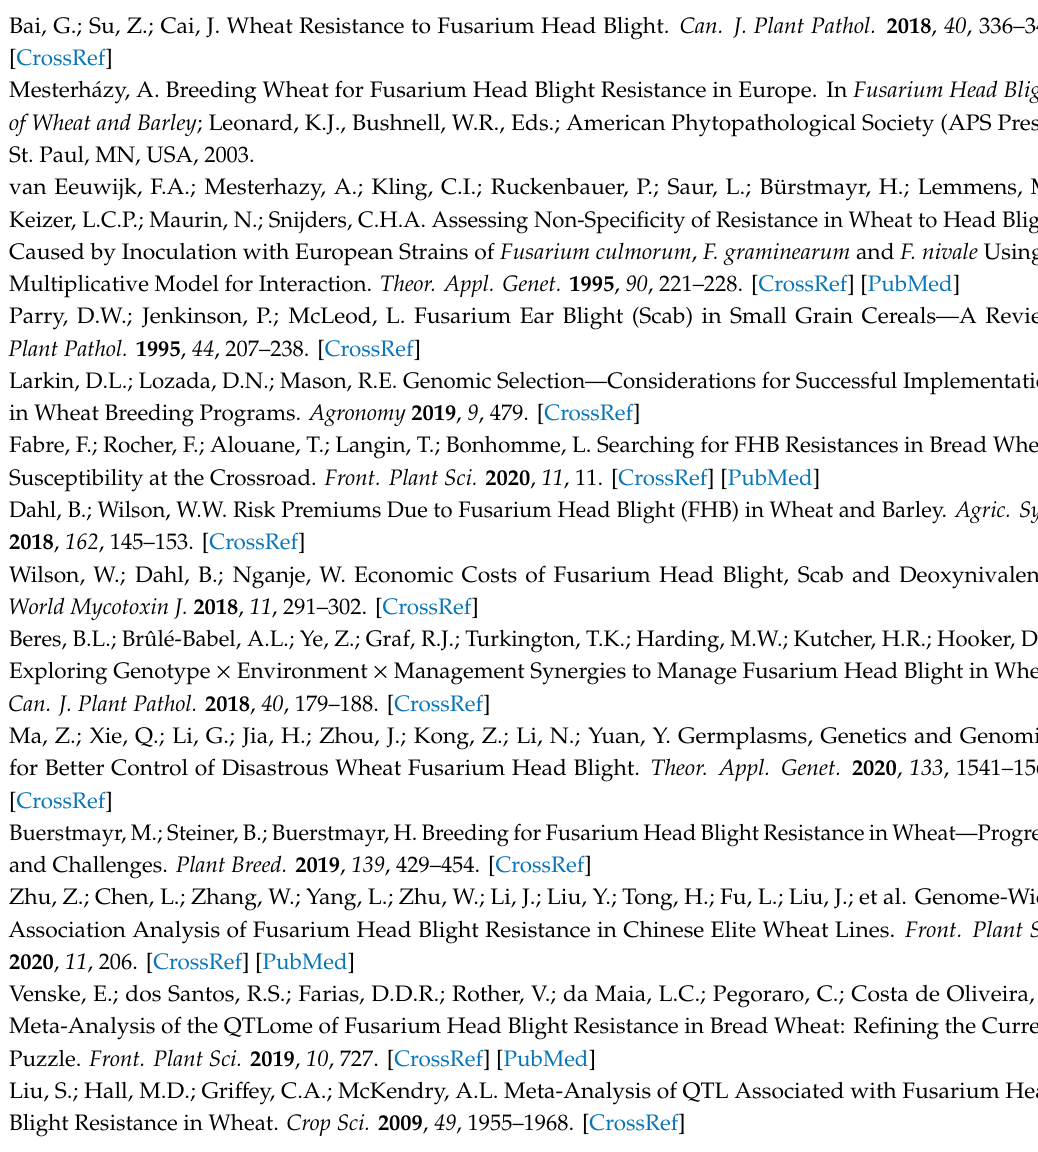
Figure S3: Correlation plots between the overlapping lines in two consecutive years: (a) 2015–2016, (b) 2016–2017, and (c) 2017–2018. Abbreviations of each trait are followed by the last two digits of the year of the respective trial. AR: Anther retention, FT: Flowering time, AU-Raw: AUDPC scores, AU-1: AUDPC scores corrected under method-1, AU-2: AUDPC scores corrected under method-2. Figure S4: Temperature profiles of each of the seasons (a) 2015, (b) 2016, (c) 2017, and (d) 2018 measured at the experimental station of the Department